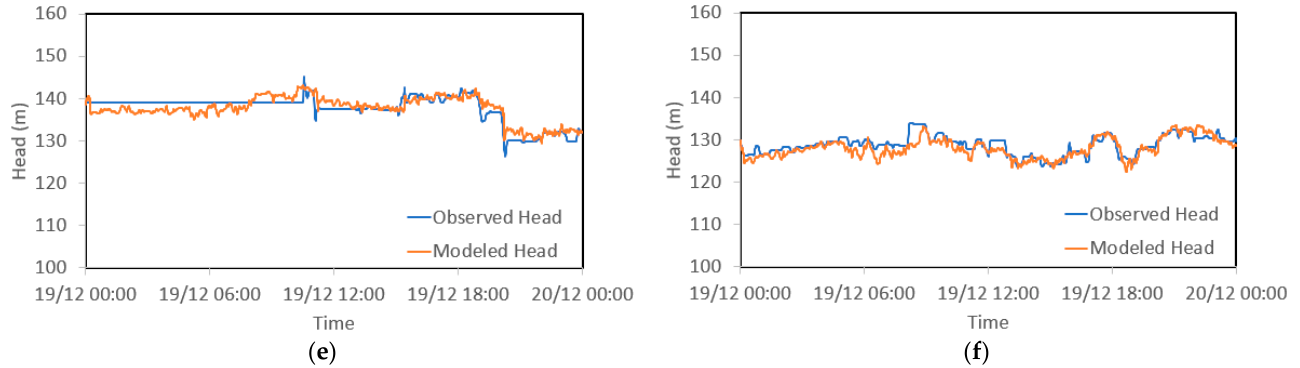
Figure 7. ( a ) Comparison of the observed and modeled system total flow during the validation period; ( b – f ): Comparison of the observed and modeled HGL at RTU1 to RTU5 during the validation period.